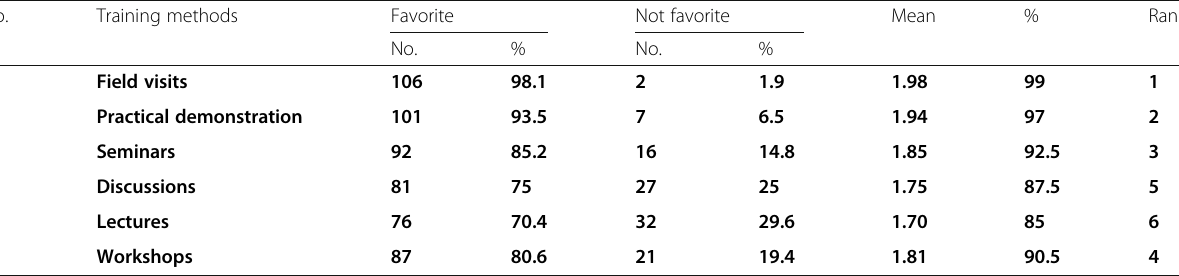
Table 6 Distribution of agricultural extension agents according to training methods they prefer for training in bio-control of fruit flies